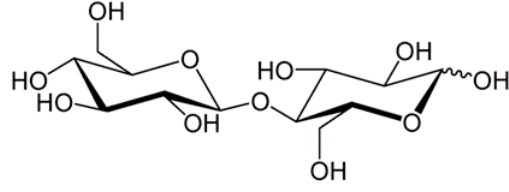
Figure 1. Cellobiose unit (redrawn from [9]).